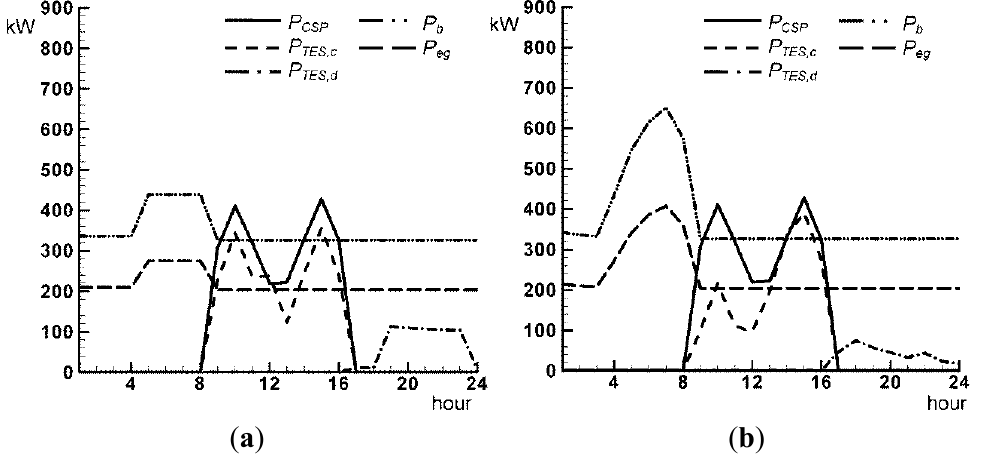
Figure 10. RES power contribution with the ( a ) thermal and ( b ) electric load tracking matching in the selected winter